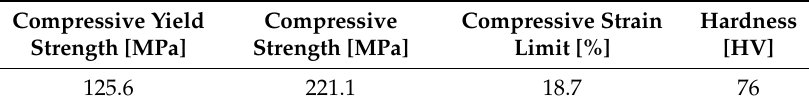
Figure 2. Optical microstructure of Mg97Zn1Y2 alloy. Table 1. Mechanical properties of Mg97Zn1Y2